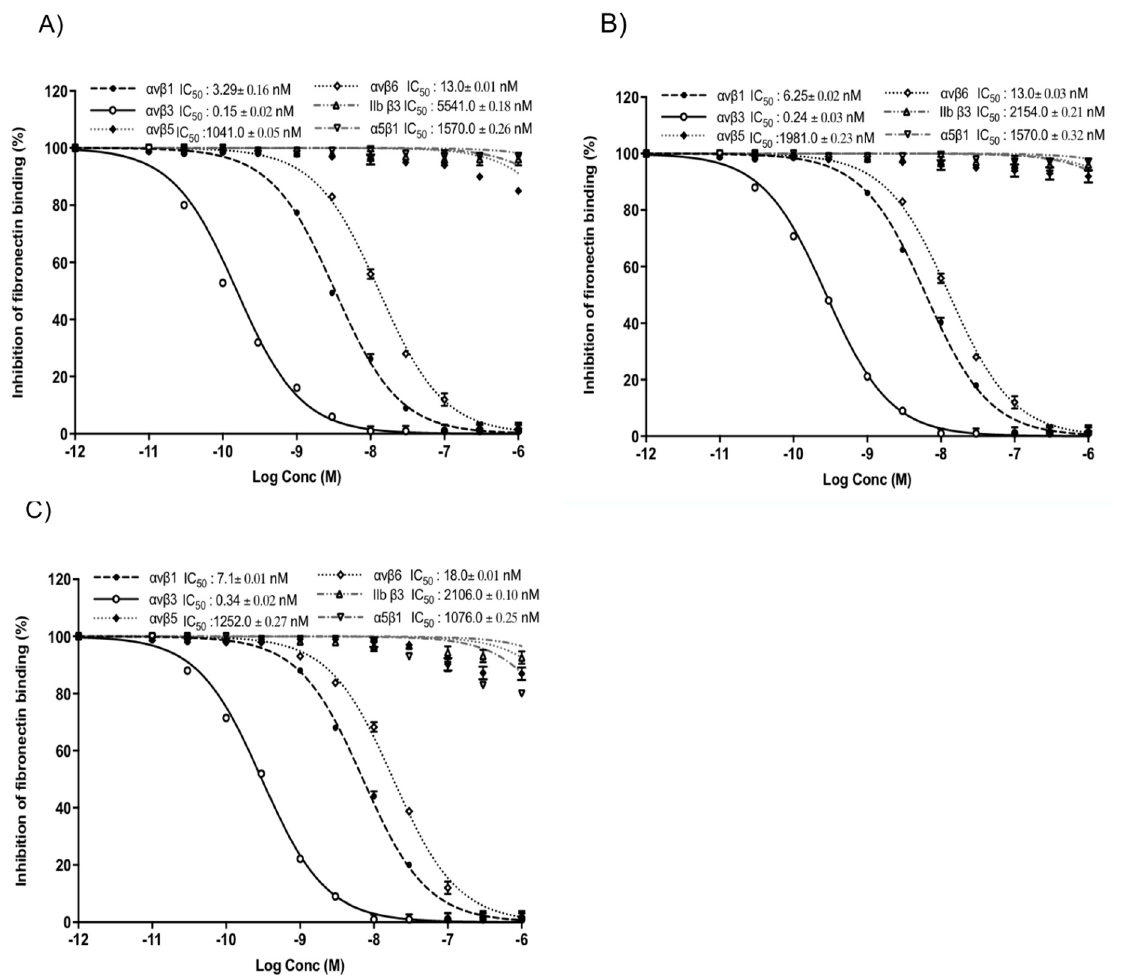
Figure 3. Binding affinity of TATs for the integrins α v β 1, α v β 3, α v β 5, α v β 6, IIb β 3, α 5 β 1, and α v β 3. ( A ) Compound 1 , ( B ) Compound 2 , ( C ) Compound 3 . Dose-response curve (mean IC 50 (nM) ± SD) of three independent experiments. x -axis show Log Concentrations from − 12 to − 6.